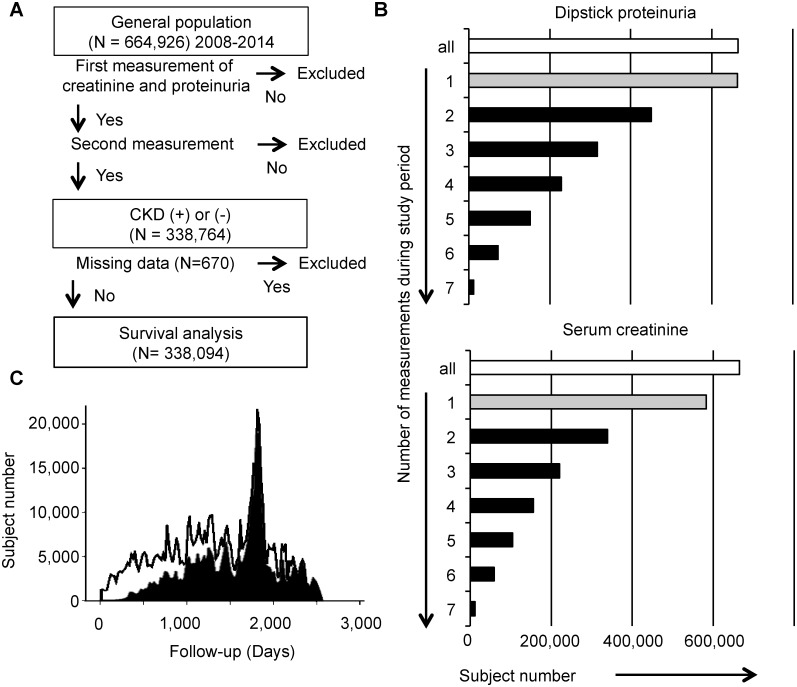
Study design.A. Strategy of recruitment of the study population, follow-up, and outcome analyses. Two annual measurements either of proteinuria or of serum creatinine enable definitive diagnosis of chronic kidney disease (CKD). B. Subject number having checked dipstick proteinuria and serum creatinine with various frequencies in this study population. The white bars mean all healthcheck participants, and the gray bars indicate their proportions with at least one measurement. Subjects with more than one check (ie, 2 to 7 times) represented by the black bars were recruited. C. The histograms present all healthcheck participants (black line) and the study population included in survival analyses (black filled). Abbreviations: CKD, chronic kidney disease.